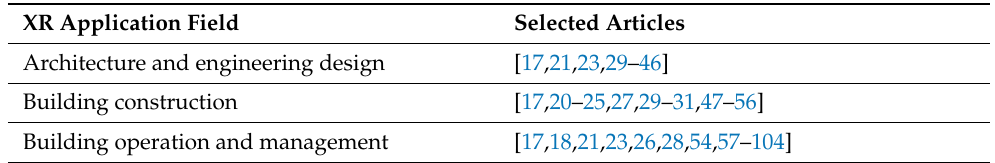
Table 1. Selected literature for review.